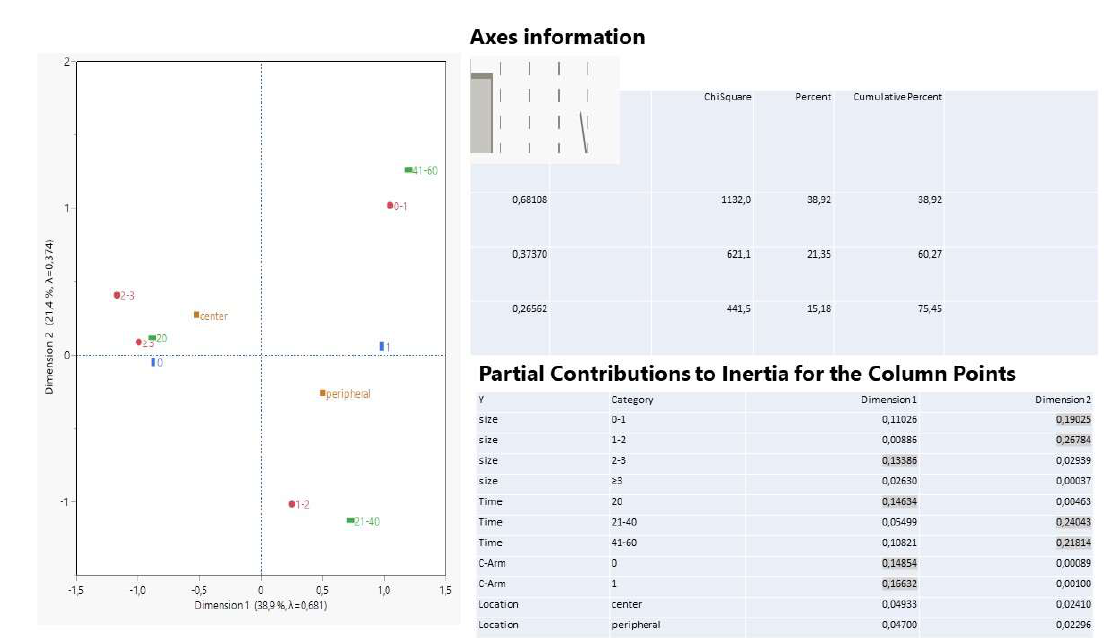
Figure 6. Multiple correspondence analysis among categories of four variables: tumor location, lesion size, operation of C-Arm, and time duration. Points positioned in close approximation indicate strong affiliation and distant points, from the center, indicate a strong effect on either dimension. The highlighted coordinates reveal a comparatively higher correlation with each dimension.